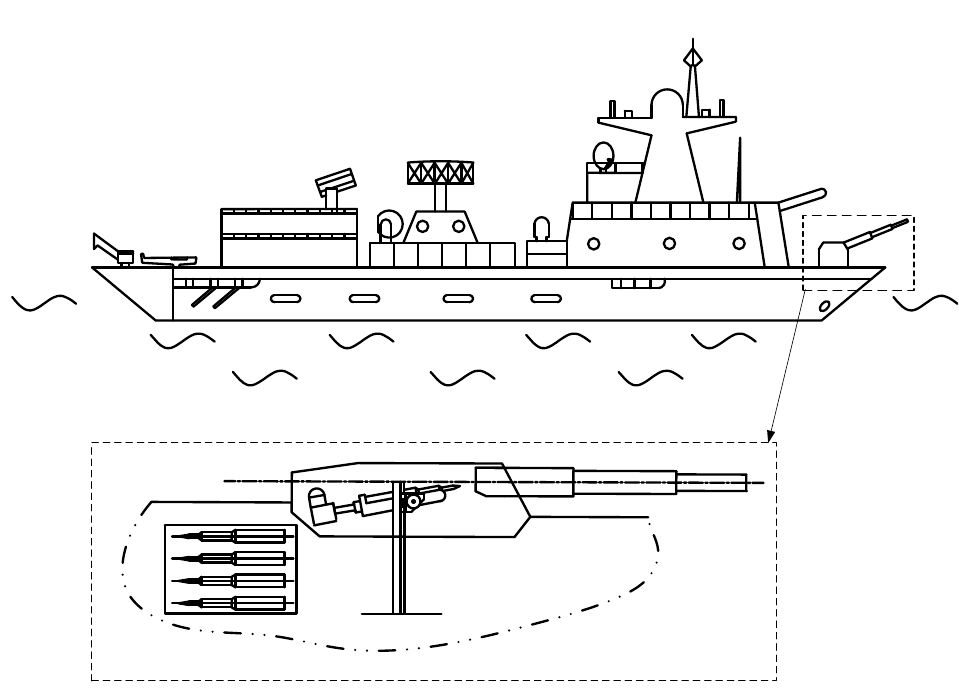
Figure 1. The ammunition transfer manipulator mounted on an oscillating